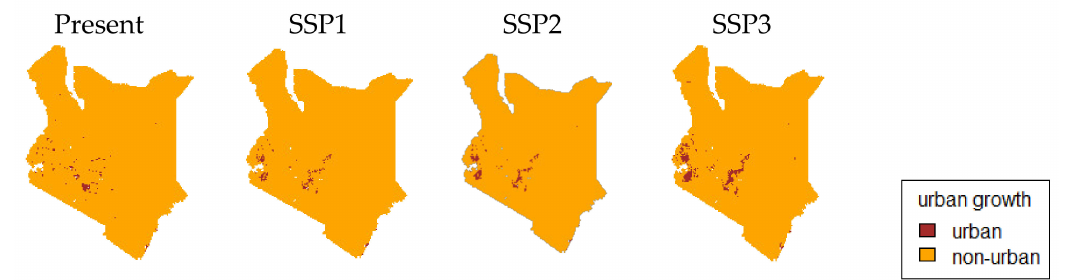
Figure 3. Present and projected future population densities according to 3 shared socioeconomic pathway (SSP) scenarios.